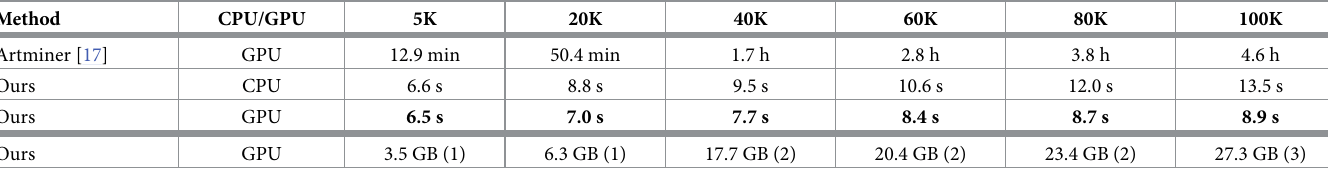
Table 5. Comparison of search speed and index size.